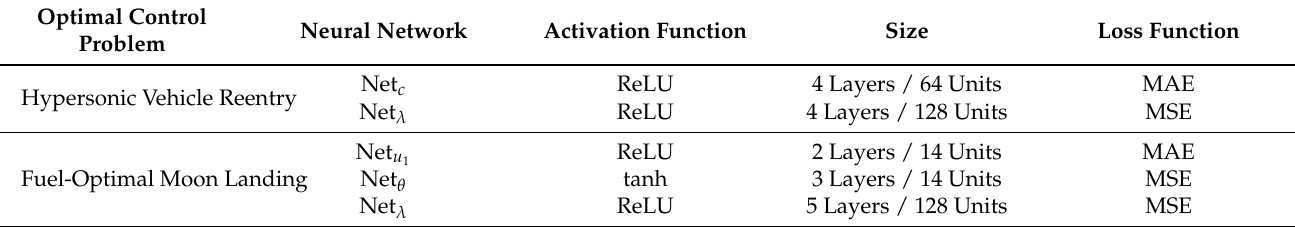
Table 5. Network structure of the DNNs for two